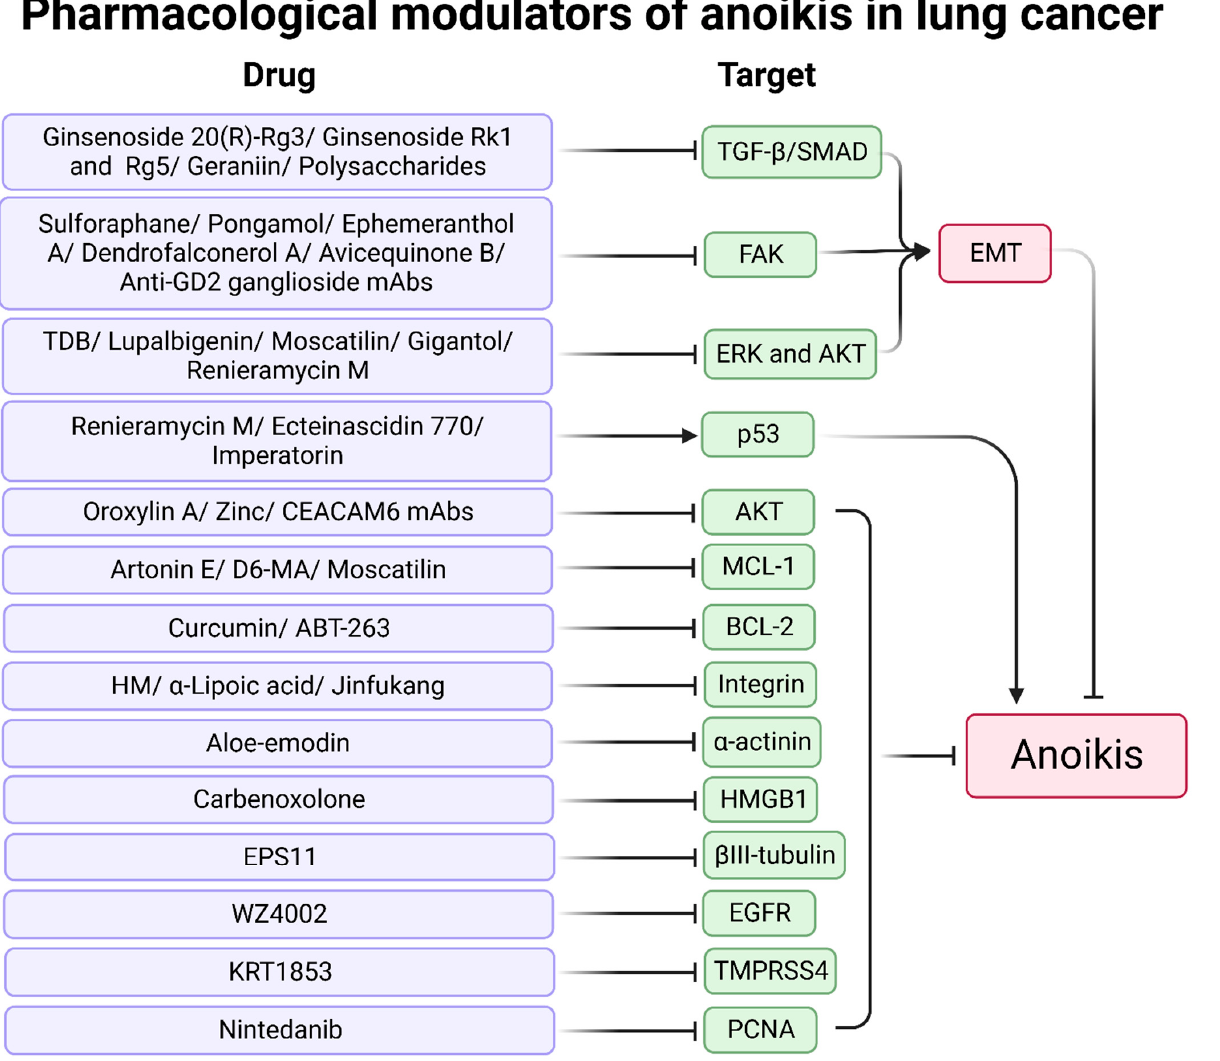
Figure 6. Pharmacological modulators of anoikis in lung cancer. FAK is associated with cell adhesion, and inhibition of FAK contributes to